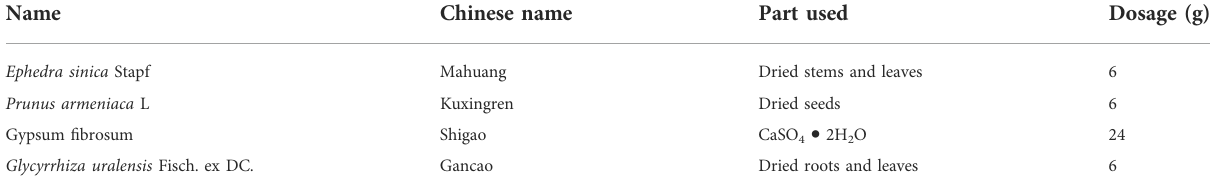
TABLE 1 Composition and dosage of Maxing Ganshi Decoction